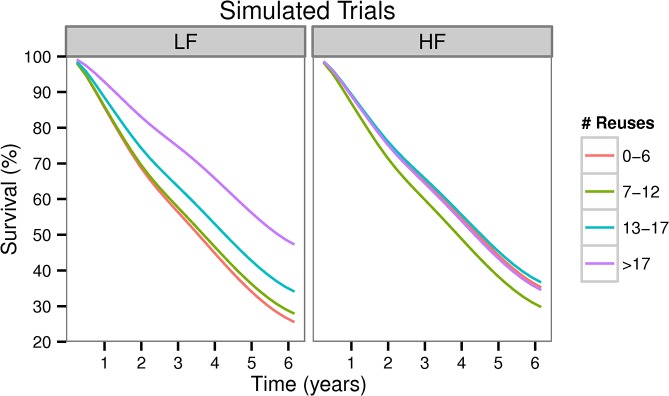
Predicted survival curves obtained by dynamic simulations of Joint Models.These were derived by counterfactually exposing HEMO study participants to all possible flux and reuse combinations. Individual survival probability curves were averaged at each observation point and these population averaged curves are depicted separately for low flux(LF) and high flux(HF) dialysis. Five year survival probabilities (P5, estimate and 95% Credible Interval) were as follows: 33.8% (28.0%-39.4%), 36.1% (30.8%-41.0%), 42.4% (36.9%-47.8%) and 55.6% (49.3%-55.8%) for increasing reuse of LF membranes. P5 (estimates and 95% Credible Intervals) for increasing reuse of HF dialyzers were: 43.7% (37.4%-49.1%), 38.% (32.9%-43.5%), 44.8% (38.1%-50.7%) and 43.0% (37.0%-49.1%).